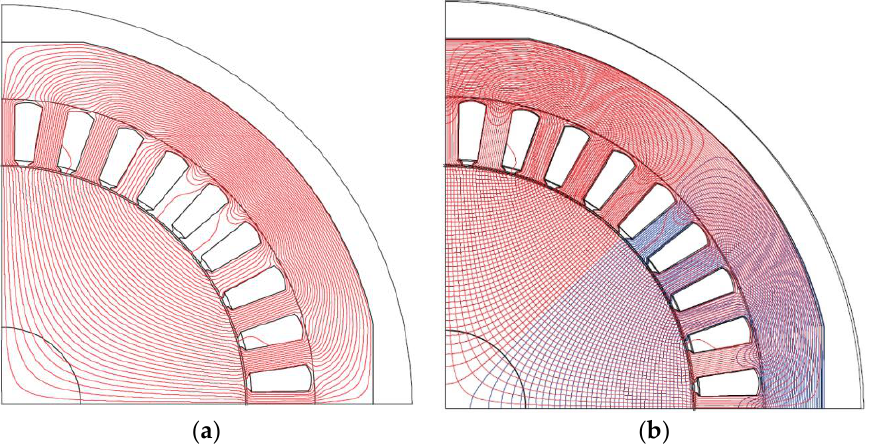
Figure 3. Flux lines of a solid rotor of a SynRM: ( a ) d − axis; ( b ) d − and q − axes. The lines of d -axis are perpendicular to these of q -axis demonstrated in the right side